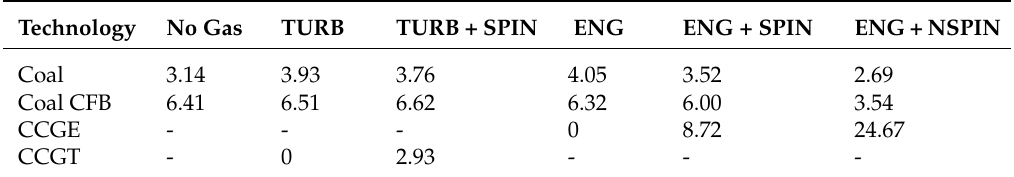
Table 3. The utilization of different technologies in upward reserves (instantaneous and regulating). Reported units are in percentage